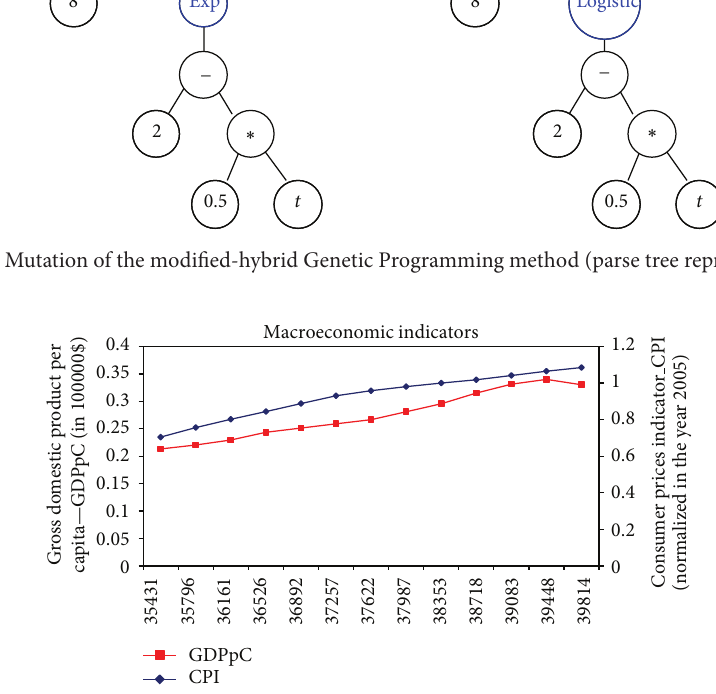
Figure 9: Yearly growth of the GDPpC (in 100000$) and CPI (normalized on the year